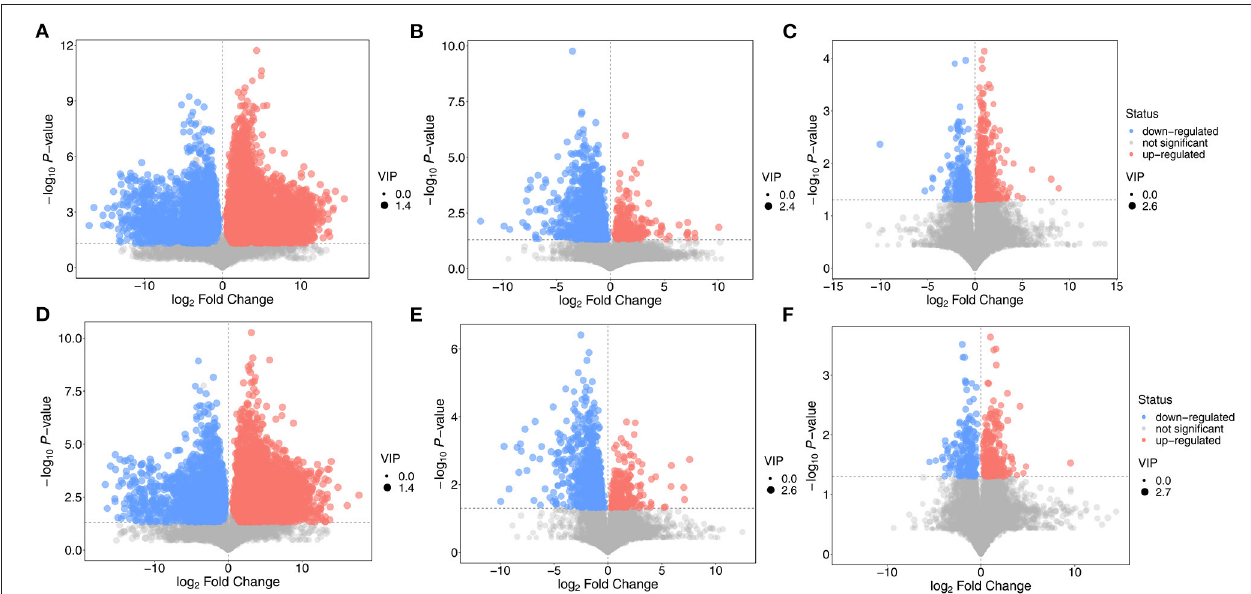
FIGURE 9 | Volcano plot of differential expressed metabolite in feces of mice. (A,D) : NT-free group compared with NT intervention group; (B,E) : basal diet group compared with NT intervention group; (C,F) : basal diet group compared with model control